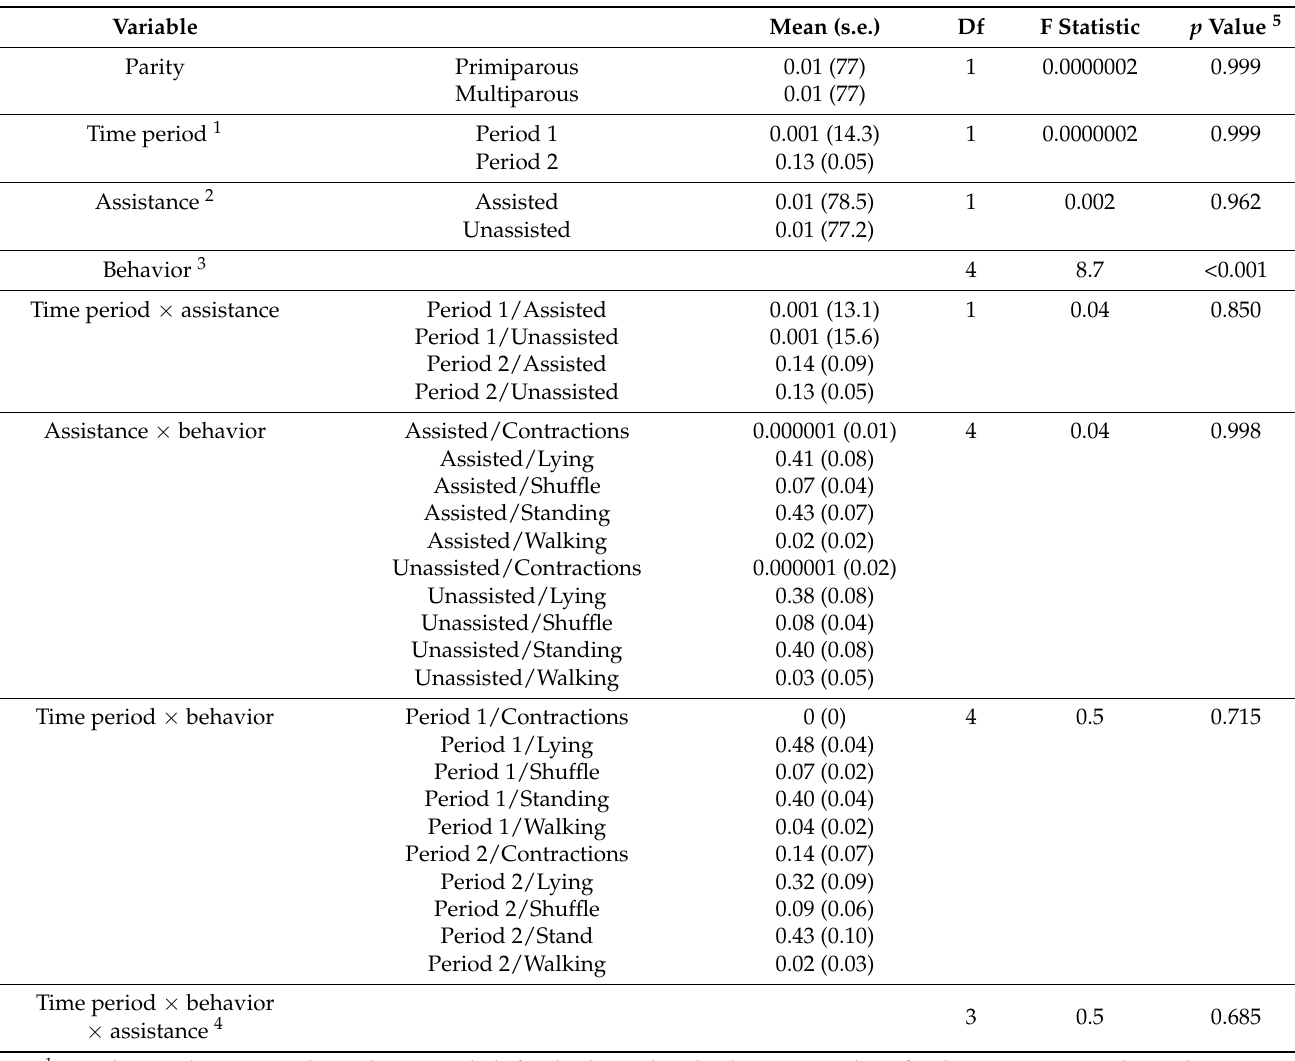
Figure 1. 4 Predicted mean values shown in Figure 2. 5 Significance was attributed at p <